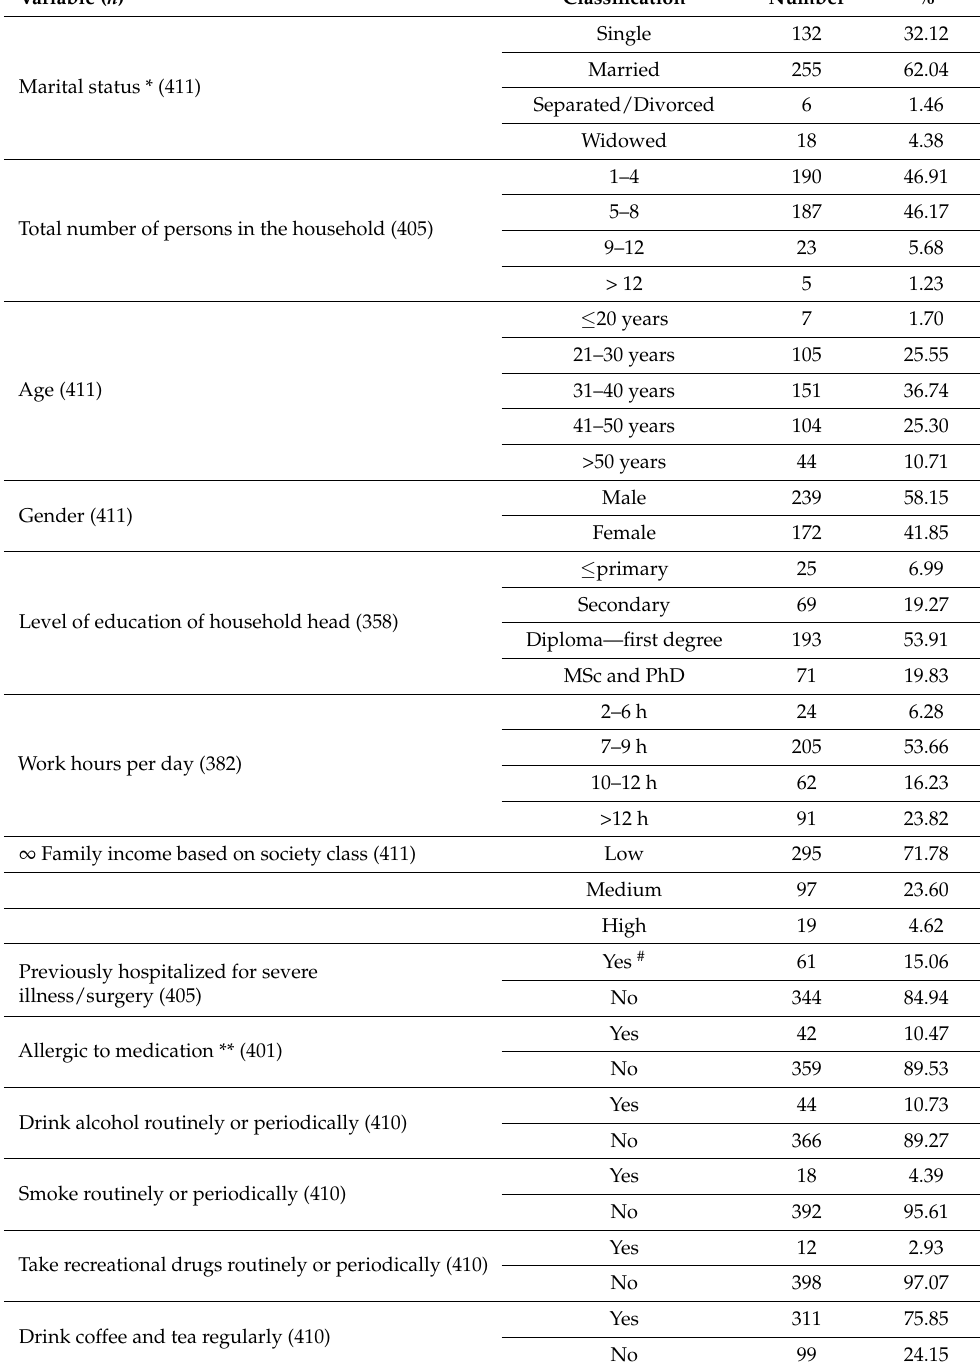
Table 1. Descriptive data of respondents regarding the psychosocial and food security-related impacts of COVID-19,